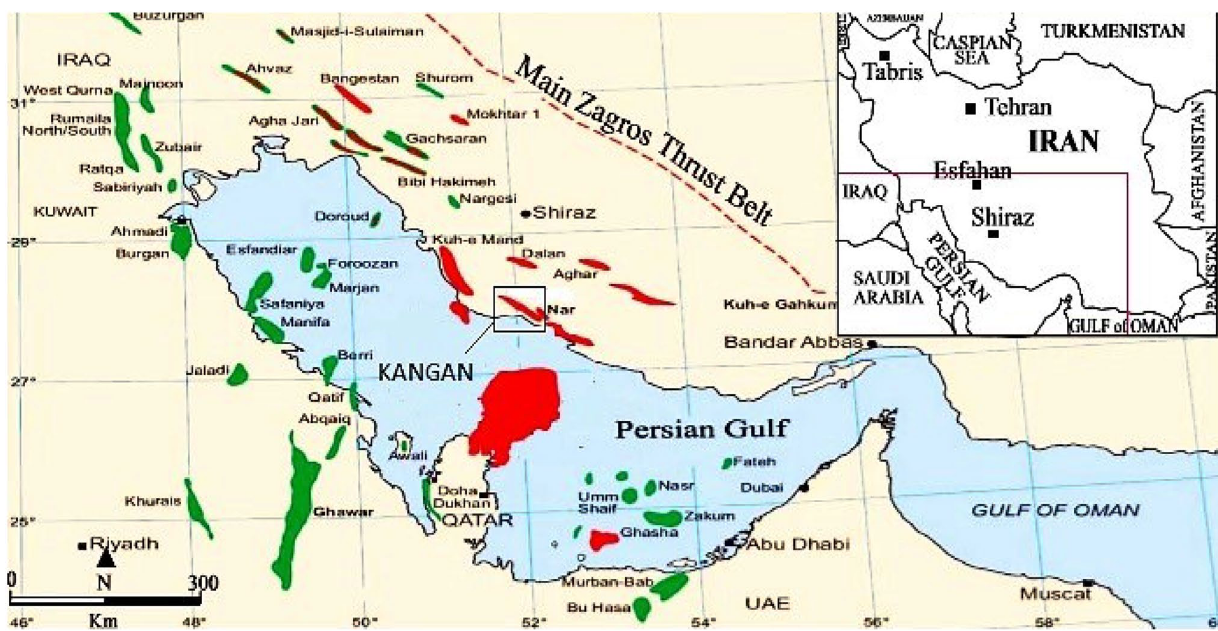
Fig. 1 Location of the Kangan gas field in Southern Iran (modified from Insalaco et al. (2006)) Fig. 2 Cenozoic to Precambrian stratigraphic column of the Zagros region and main reser- voirs of the Dalan and Kangan formations (Enayati-Bidgoli et al.